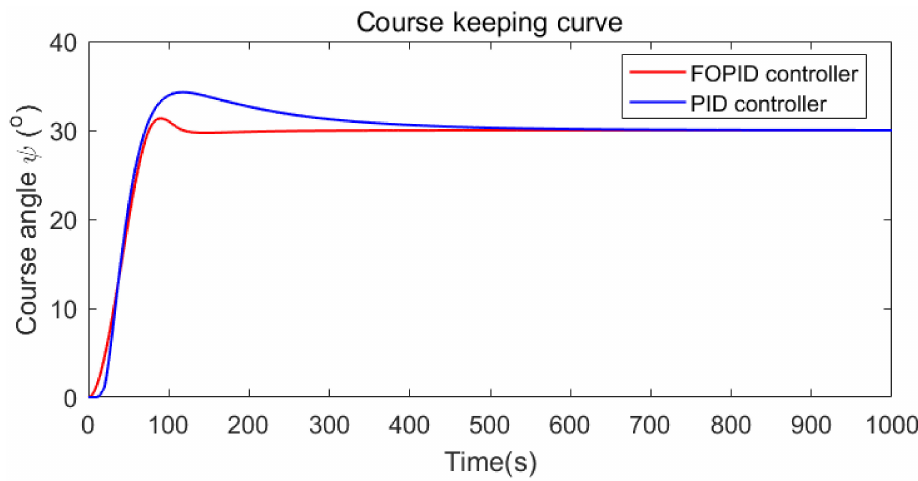
Figure 9. Course-keeping curve with FO PI λ D µ controller and the PID controller.